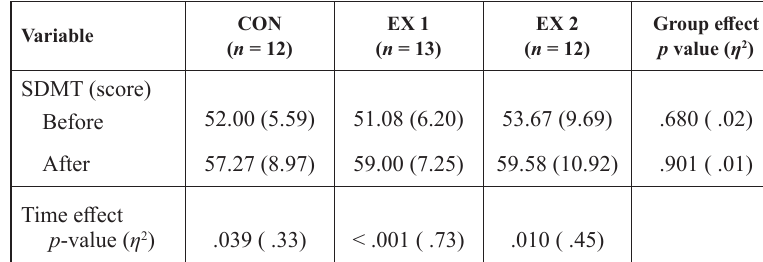
Table 2. Mean (SD) for pre-test and post-test SDMT values in two experimental groups (EX 1 and EX 2) and the control group (CON) Notes. CON – control group; EX 1 – experimental group 1; EX 2 – experimental group 2; SDMT – Symbol Digit Modalities Test; p -values were calculated via a repeated measures ANOVA (time effect) and one-way ANOVA (group effect). Figure. Relationship between cardiorespira- tory fitness (VO 2peak ) and the overall change in Symbol Digit Modalities Test (SDMT) performance after an acute bout of game- based exercises in the control (CON), light intensity (LIG) and vigorous intensity group